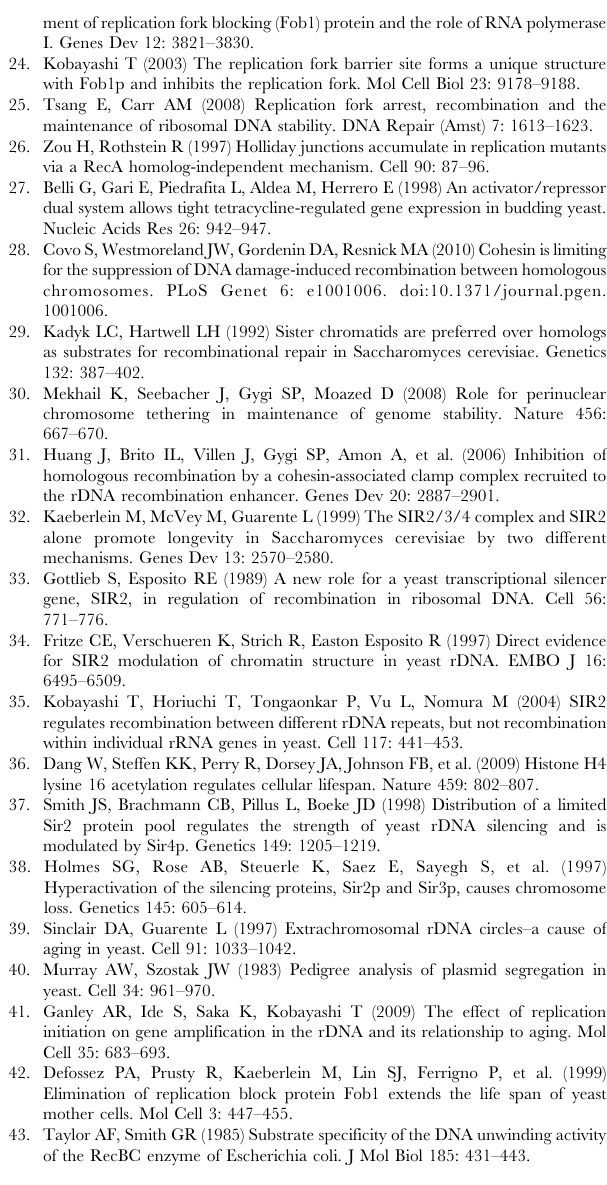
Table S3 Plasmids used in this